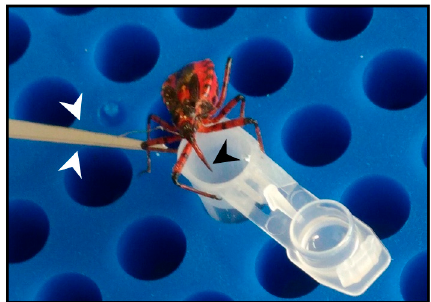
Figure 1. The European predatory assassin bug Rhynocoris iracundus . Stimulation of R. iracundus on the hind legs using entomological forceps (white arrow heads) encourages the insect to use its proboscis (black arrow head) to inject venom through laboratory film (Parafilm) stretched over a collection tube containing phosphate-buffered saline (PBS).